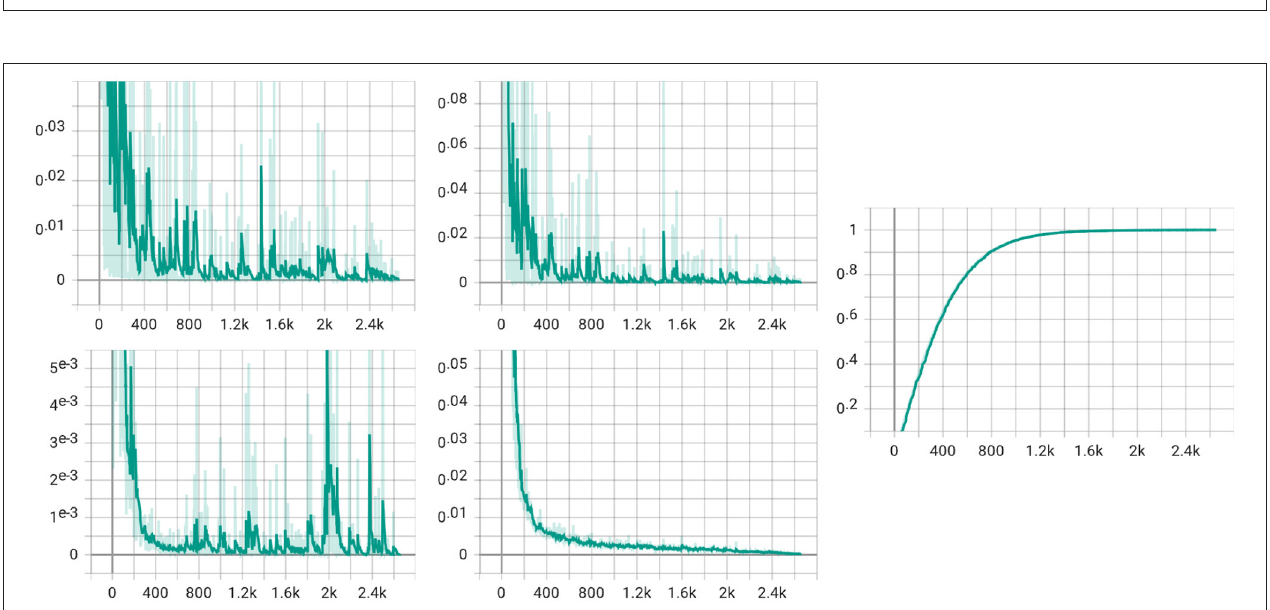
FIGURE 8 | Visualization for four loss items. The upper left is the total loss, while the classification loss is in the upper middle. The lower left is for the MMD loss, and the discrepancy loss is in the lower middle. The figure in the right is the visualization of the α in (5).